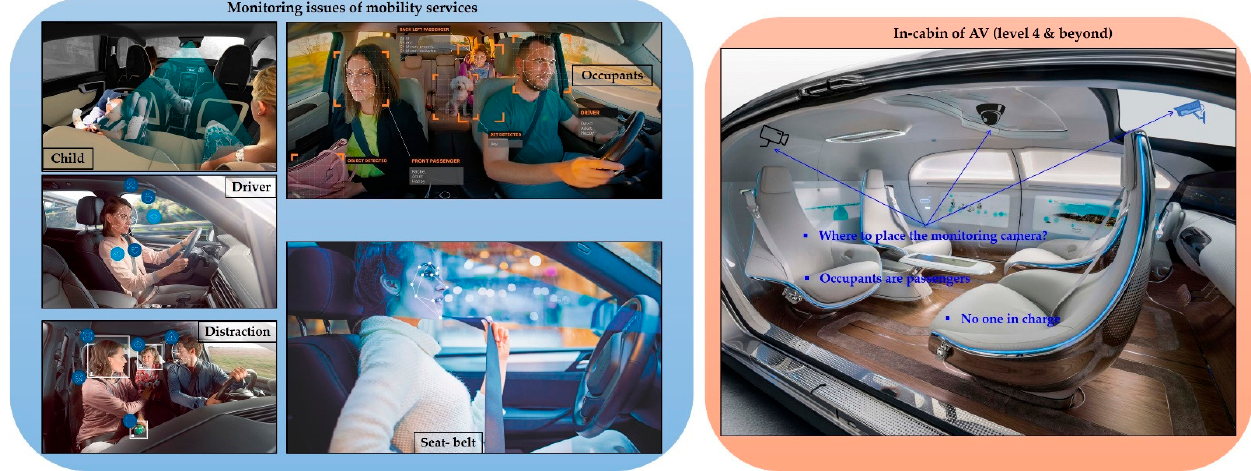
Figure 1. An illustration of the monitoring issues of mobility services and in-cabin of a level 4 and beyond AV.